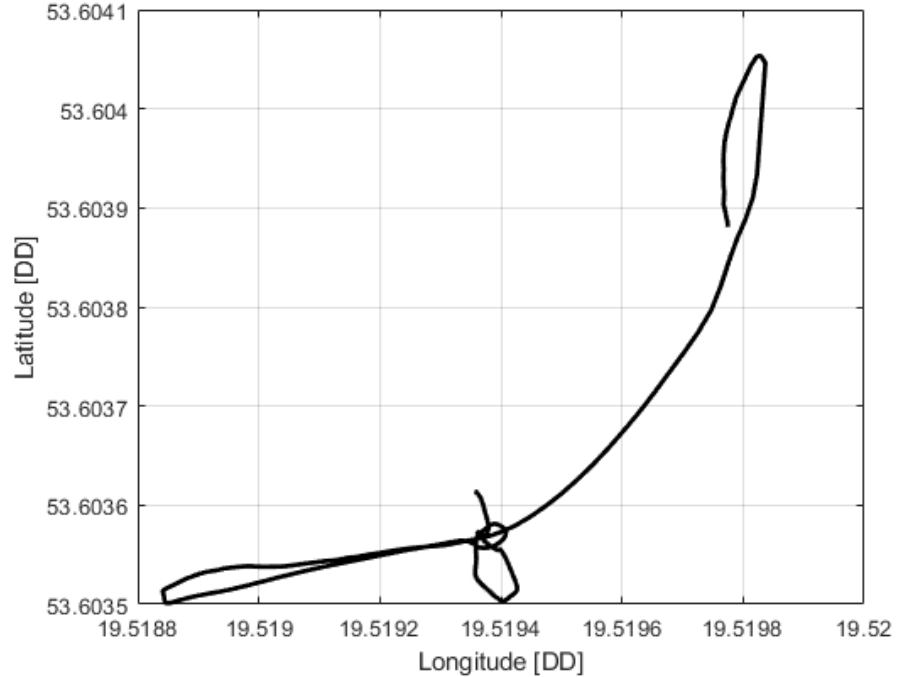
Figure 5. VTOL UAV trajectory during crash flight.